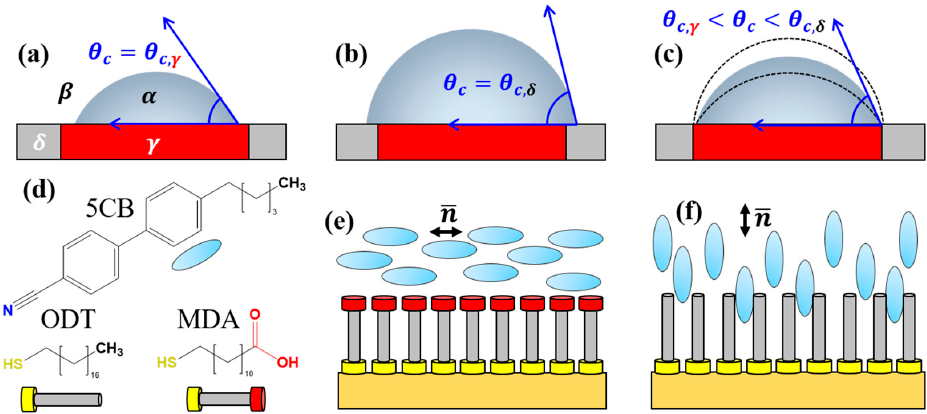
Figure 1. Contact angle of droplets on high and low energy domains. ( a ) Low contact angles are seen on high energy domains. ( b ) When the contact angle is pinned at the domain boundary, the contact angle varies. ( c ) When the droplet edge is in contact only with the low energy domain, a high contact angle is seen. ( d ) Chemical structures and schematic figures of the chemicals used in this work. ( e ) The carboxylic acid groups in MDA form a polar surface that induces planar alignment. ( f ) The long alkyl tails in ODT enforce a non-polar surface that induces homeotropic alignment.